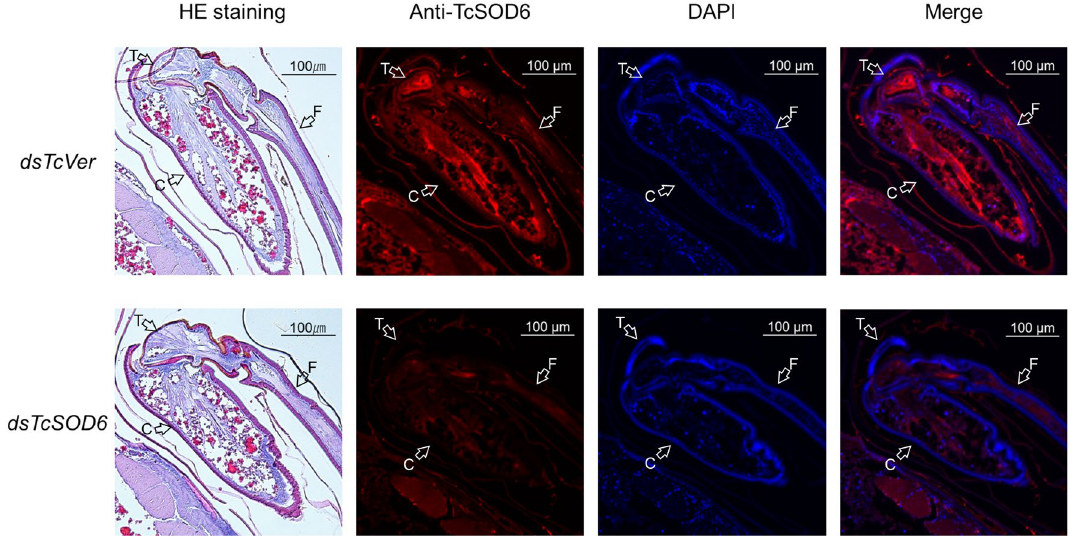
Figure 7. The fine structure of the femur, trochanter, and coxa in TcVer- and TcSOD6 -knockdown hind legs. Representative polarized light microscopy and confocal laser scanning microscopy (× 100) images obtained from pupae at day 5 in the TcVer- and TcSOD6- knockdown groups. Upper panels indicate the TcVer -knockdown control group. Lower panels indicate the TcSOD6- knockdown group. TcSOD6 protein fluorescence is shown in red, and nuclear fluorescence is shown in blue. The structure of the hind legs was observed by visible light imaging of haematoxylin and eosin-stained sections. The open arrows indicate the different parts of the hind leg; C, coxa; T, trochanter; F, femur. Bar = 100 µm.